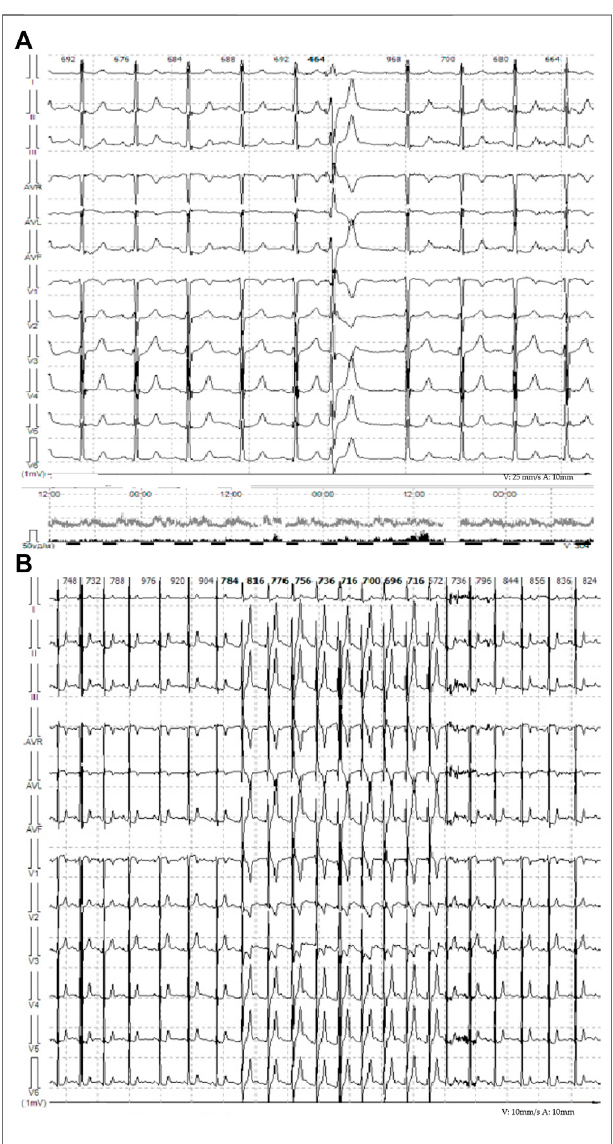
FIGURE 2 | (A) Representative ECG from telemonitoring, single monomorphic ventricular ectopic complexes. (B) Representative ECG from telemonitoring. Unstable episodes of the monomorphic idioventricular rhythm with frequency of 81 bpm are